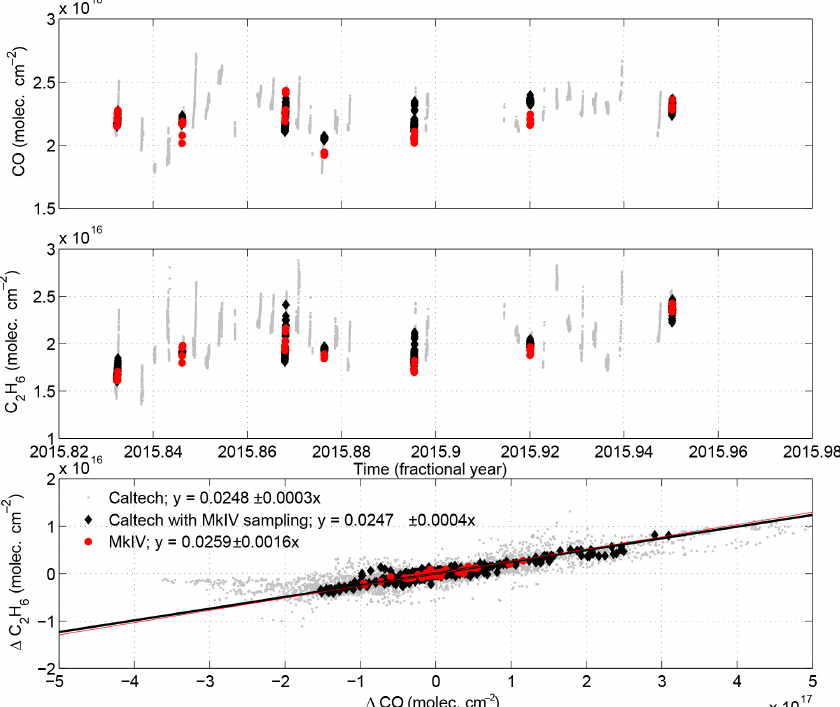
Figure C1. This figure shows the negligible impact on the derived tracer–tracer slope from the different sampling strategies used by the MkIV and Caltech measurements. The top panel shows the time series for CO total column abundances for Caltech (grey), MkIV (red), and the subsampled Caltech values to coincide with the MkIV measurements (black). The middle panel shows the C 2 H 6 time series. The bottom panel shows the tracer–tracer relationship between the diurnal anomalies of the trace gases. The slopes computed for the three cases agree well within